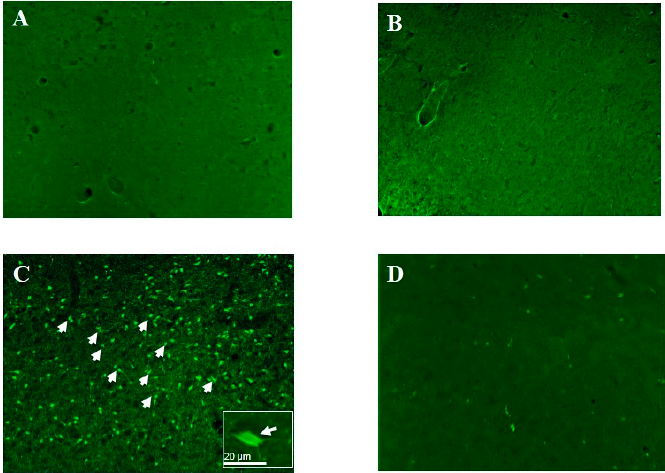
Figure 2. Pretreatment with a single injection of ALA reduces the number of Fluoro-Jade C-positive neurons. Young adult Sprague-Dawley male rats were administered ALA (500 nmol/kg) by intravenous